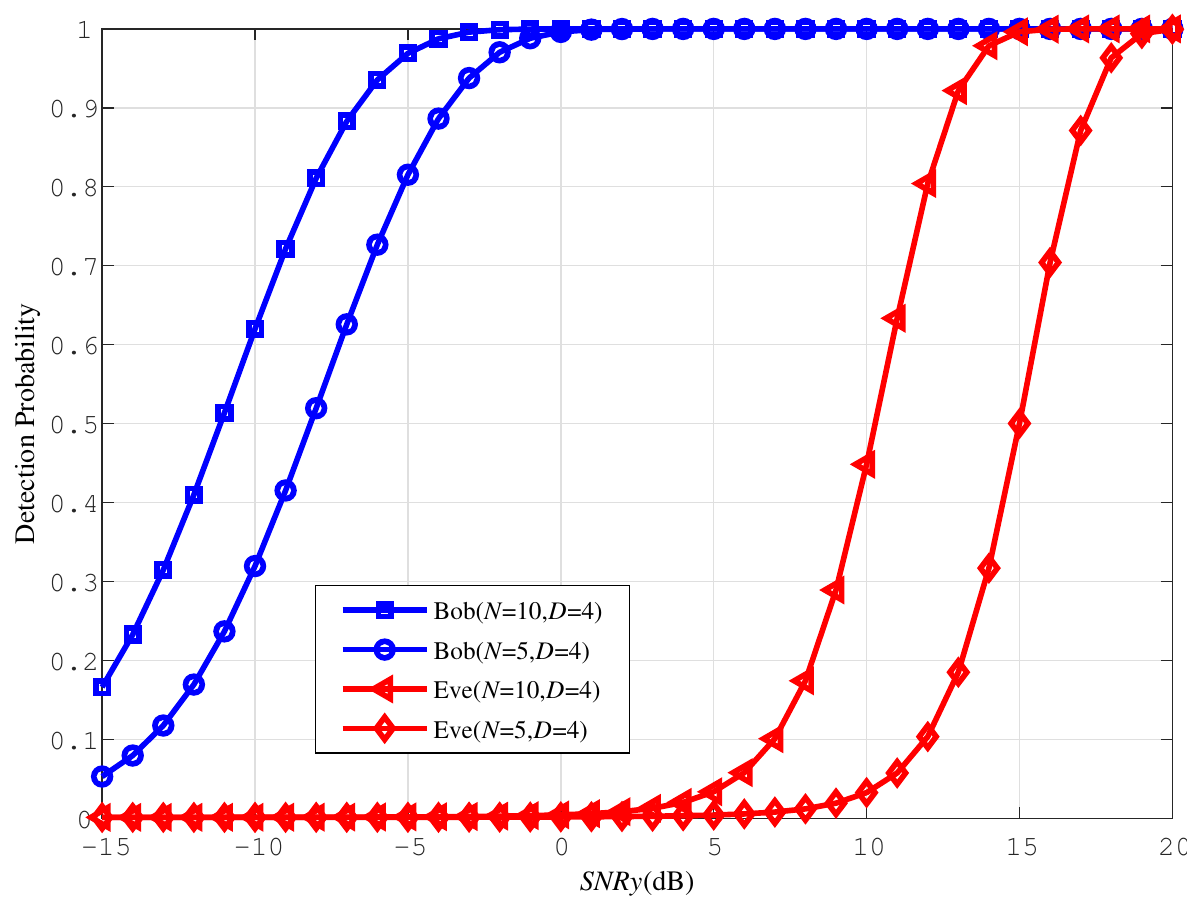
Figure 8. Signal detection performance of Bob and Eve over fading